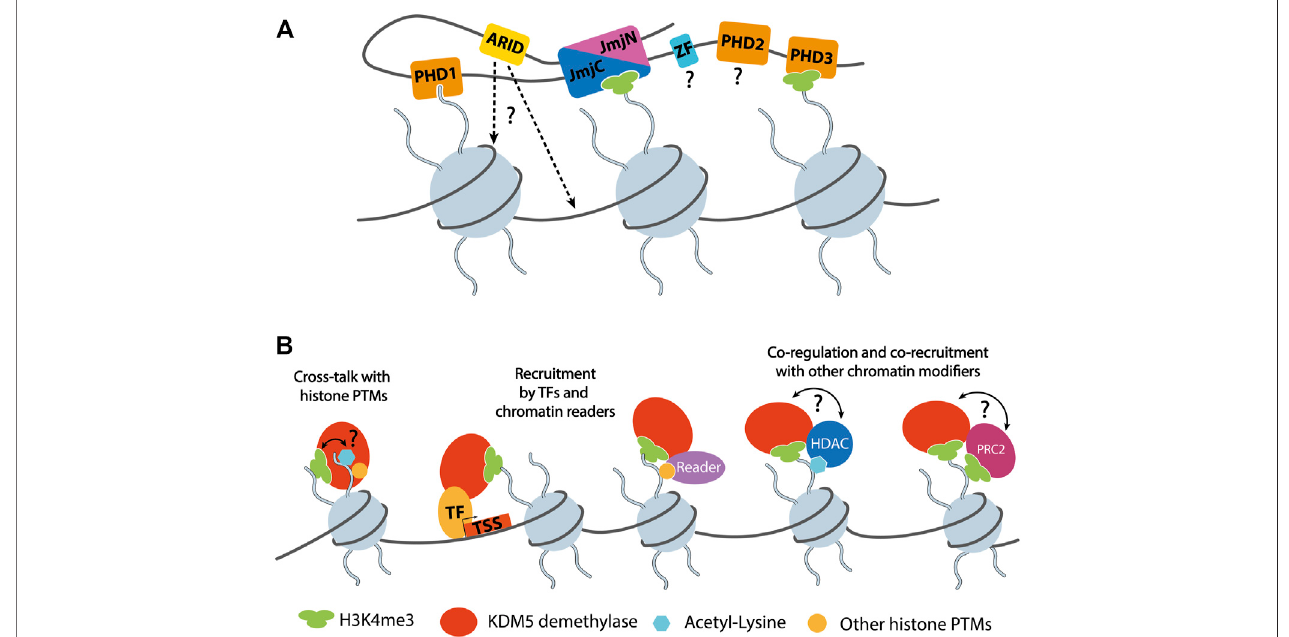
FIGURE 3 | (A) Schematic representation of KDM5 interactions with chromatin. The catalytic composite JmjN/C domain binds the substrate H3 tail harboring methylated H3K4 (depicted as H3K4me3 for simplicity). Two of the PHD domains, PHD1 and 3, were shown to interact with unmethylated and trimethylated H3K4, respectively. The ARID domains are known DNA binding domains with a role in KDM5 chromatin targeting. How DNA binding is mediated in the context of full-length KDM5proteinsiscurrentlyunknown,sincethearrangementofJmjCandARIDdomainsseemstobeincompatiblewiththebindingofnucleosomalDNA,according to homology models (Horton et al., 2016). The roles and potential chromatin interactions of the C5HC2 and PHD2 Zn fi ngers are unknown. Note that the depiction of threenucleosomeswaschosenforclarity.ItisnotknownhowmanynucleosomesareboundbyasingleKDM5proteinsimultaneously. (B) FunctionalKDM5interactions on chromatin. So far, only the binding of unmethylated H3K4 has been shown to regulate the demethylase activity of KDM5s. Given the potential interactions with HDACs, a direct or indirect responsiveness to other histone PTMs such as acetylated lysines, is conceivable. KDM5 proteins are recruited by transcription factors (TFs), reader domain proteins, or mediated by the association with other epigenetic regulators such as HDAC complexes or PRC2. The interaction and functional interplay of KDM5swithHDACcomplexesandPRC2suggestsapotentialmutualregulationofdemethylaseandotherchromatinmodifyingactivities.Suchadirectinterplayremains to be demonstrated